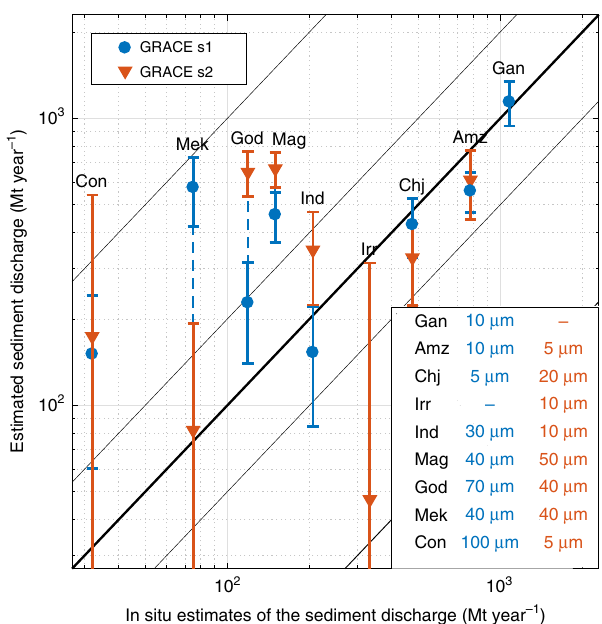
Fig. 4 GRACE satellite-derived sediment discharge (SSD) with standard deviation vs. in situ suspended sediment discharge. For clarity, we only show positive values of SSD for grain sizes (bottom right subpanel) that better compare with in situ sediment discharge for each hydrological correction (s1 and s2). Ganges-Brahmaputra (Gan) and Irrawaddy (Irr) have negative SSD for s2 and s1 solutions, respectively. Amz: